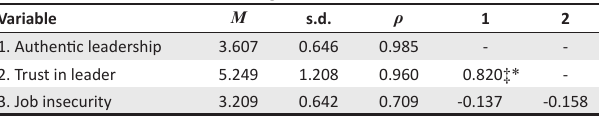
TABLE 3 : Correlation matrix containing means, standard deviations and reliabilities. Variable M